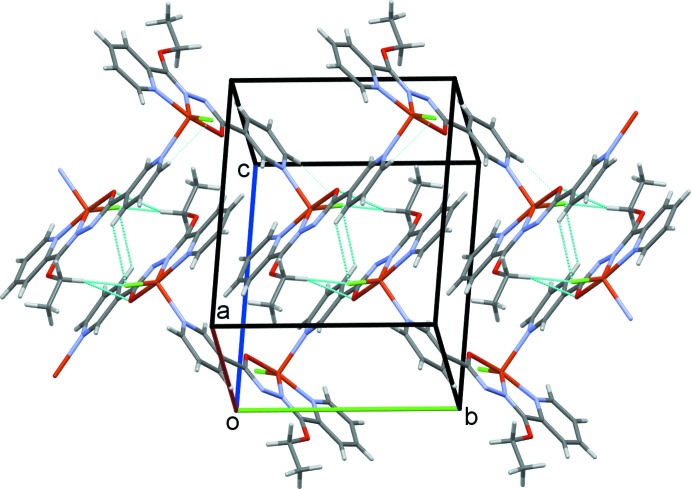
A view of the crystal packing of complex I.